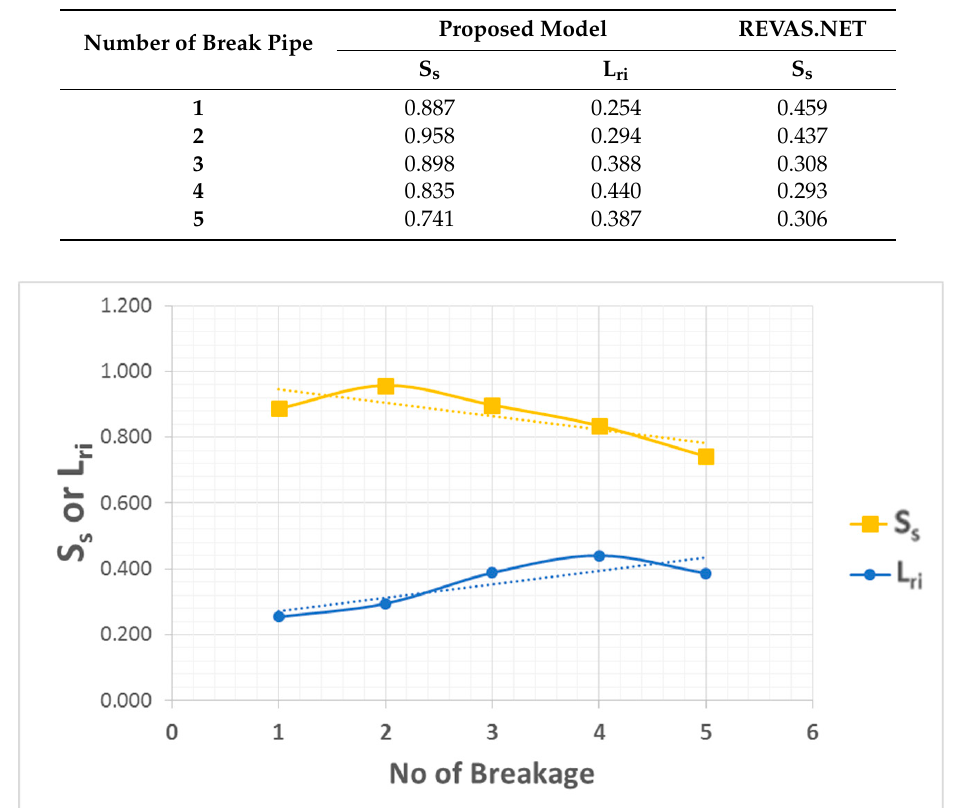
Table 7. Results of the proposed model and REVAS.NET according to the number of break pipes.